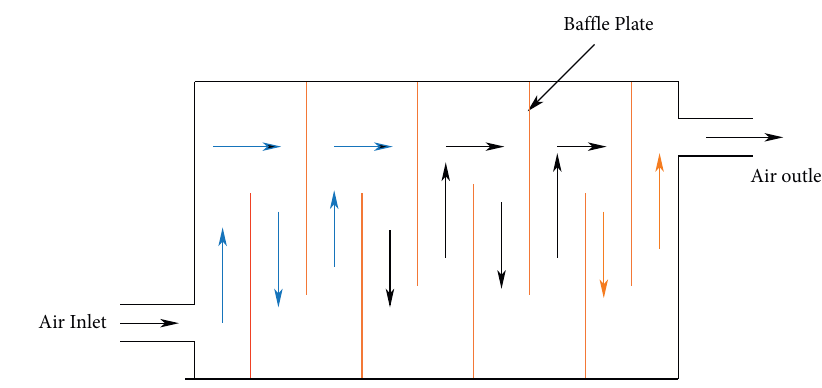
Figure 2: Flow of air inside the solar air heater. Table 1: Accuracy and range of measuring